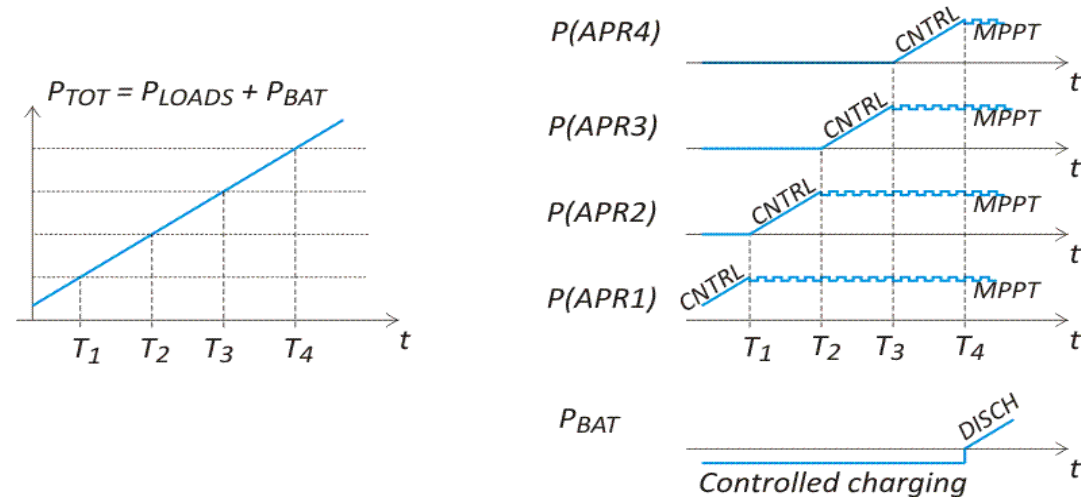
Figure 4. Power-up sequence in a SMPT regulator with four solar array sections. Left plot: overall power absorption vs. time. Right plot: power supplied by the single APRs and by the battery.